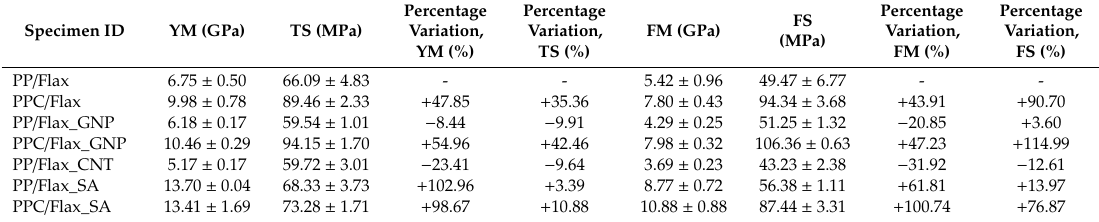
Table 1. Summary of the tensile and flexural properties of the composite materials based on polypropylene (PP) and modified flax fabrics (YM = Young’s modulus; TS = Tensile strength; FM = Flexural modulus; FS = Flexural strength; percentage variation is in reference to the corresponding property of PP/Flax).